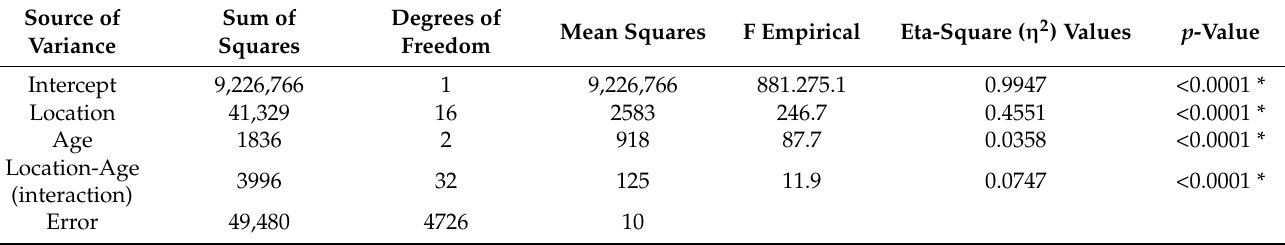
Table 7. Effect on wood hardness of location and tree age and the interaction of these factors (two-way analysis of variance). Source of Sum of Variance